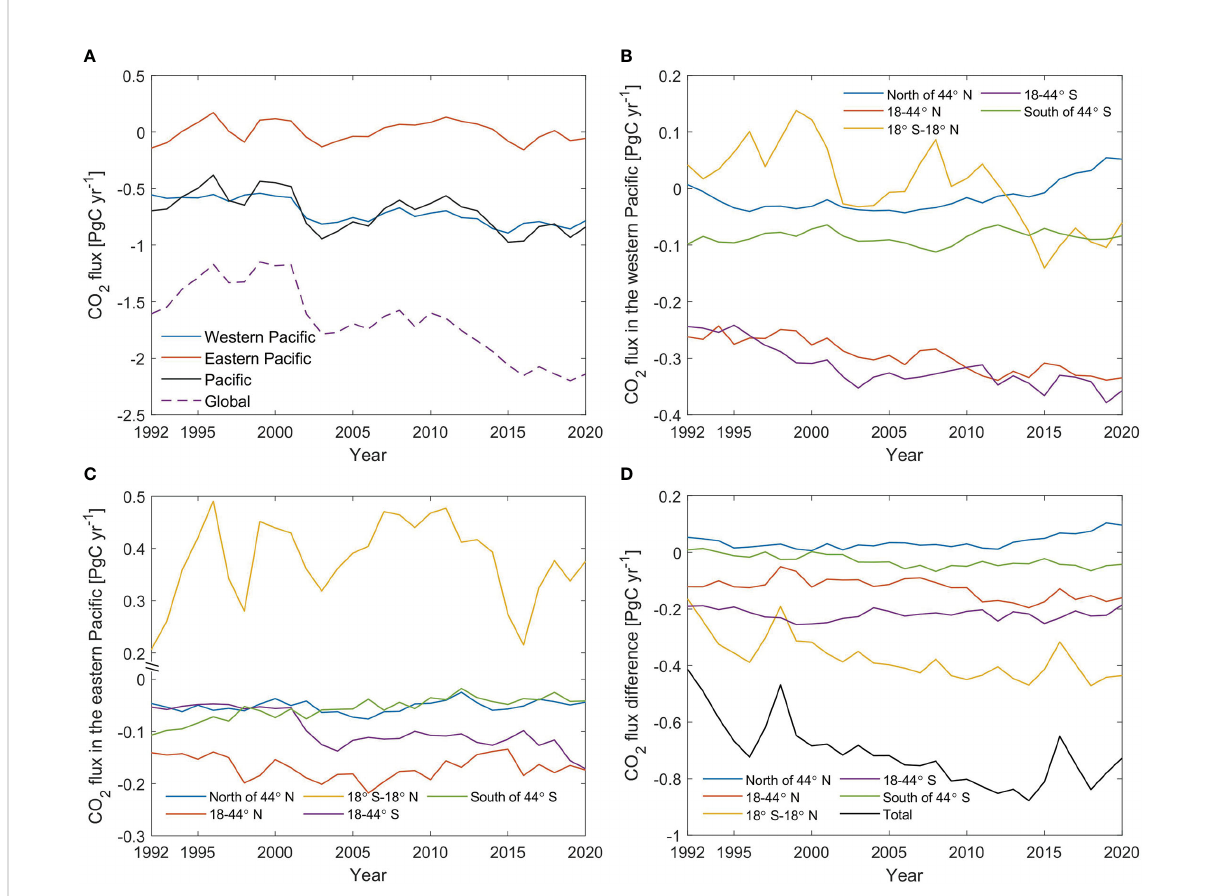
FIGURE 4 Interannual variability of sea-air CO 2 fl ux and the west-east difference in the Paci fi c. (A) : total CO 2 fl ux of the western and eastern Paci fi c; (B) : total CO 2 fl ux in different latitudes of the western Paci fi c; (C) total CO 2 fl ux in different latitudes of the eastern Paci fi c; (D) : the west-east difference of CO 2 fl ux in different latitudes ( fl ux west - fl ux east